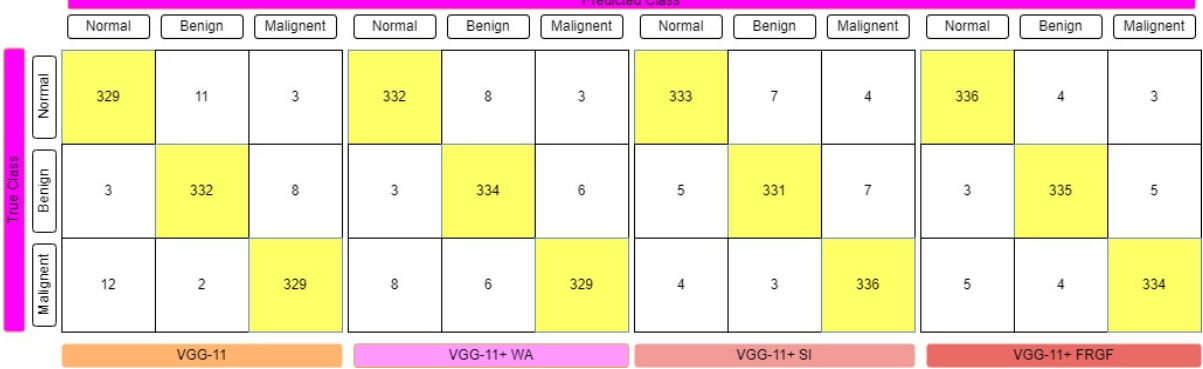
Figure 12. Confusion matrix representation of Inception V4 deep CNN model with various fuzzy ensemble technologies. Inception V4, Inception V4+ WA, Inception V4+ SI, and Inception V4+ FRGF